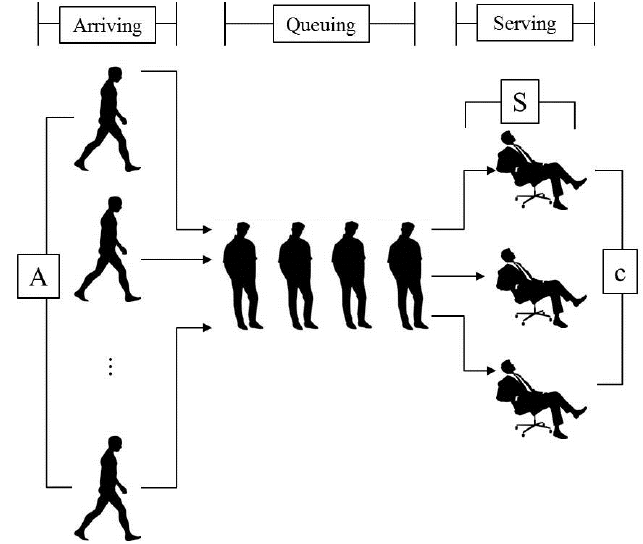
Figure 2. A general queuing model of Kendall’s